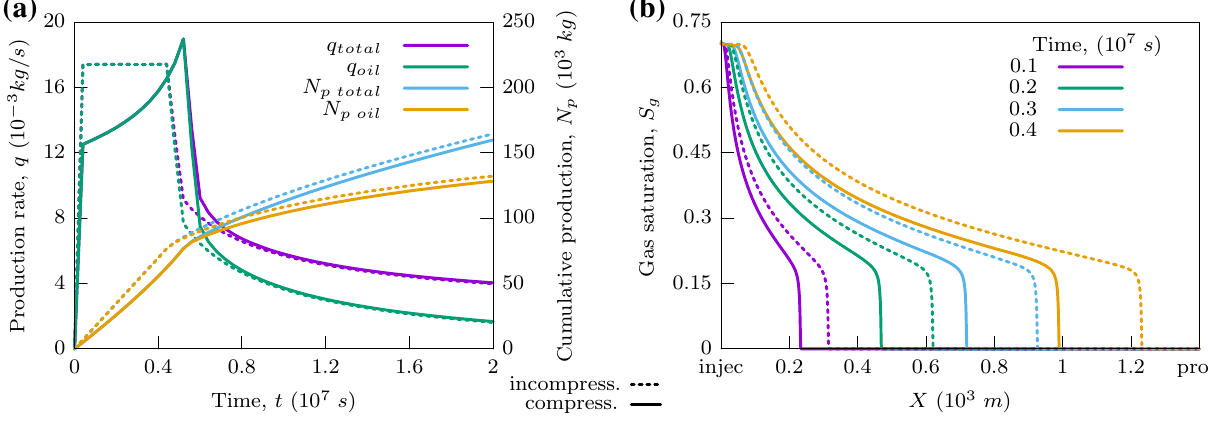
Fig. 6 Injectant gas CH 4 . 1D model. Scenario 4. Comparison of compressible and incompressible cases. a Production profiles. b Saturation